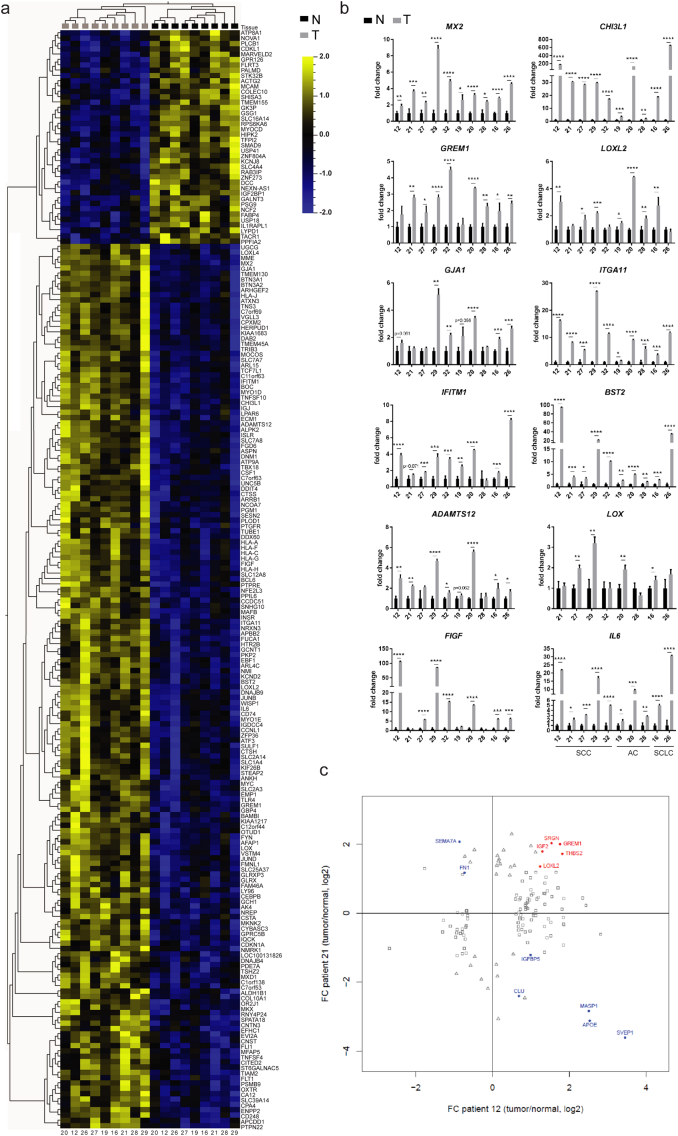
Comparison between primary samples of paired N- and T-MSCs.(A-B) Comparison between the expression profile of N- (black) and T-MSC (grey) samples isolated from the same patients. (A) Microarray heatmap showing a distinct mRNA expression profile between paired samples from 9 patients. Log2 expression values are indicated by a color scale: up-regulated genes are depicted in yellow, down-regulated genes in blue. Each column represents a MSC sample (patient identification numbers (ID) are reported at the bottom) while rows represent genes identified by symbols on the right of the heatmap. Dendrograms are based on hierarchical clustering of samples/variables. (B) Validation by quantitative Real-Time PCR of selected genes. Samples are ordered according to tumor subtype (SCC, AC or SCLC) and patient ID are indicated below each graph. For all genes and for each patient (n = 10), expression was normalized to N-MSC levels using the PP1A housekeeping gene. Median values and SD from triplicates are shown. Paired N- and T-MSC expression levels were compared using multiple t tests. Significant differences were indicated according to the level of significance: * at P ≤ 0.05; ** at P ≤ 0.01; *** at P ≤ 0.001; **** at P ≤ 0.0001. (C) Secretome analysis of paired N- and T-MSC samples from patients 12 and 21. In red, proteins found to be significantly up-regulated in both T-MSC samples. In blue, proteins found to have significantly different abundance in the two samples but in opposite direction. Squares represent significant differentially secreted proteins from patient 12, triangles from patient 21. See also Fig. S3 and Table S1. (For interpretation of the references to color in this figure legend, the reader is referred to the web version of this article.)